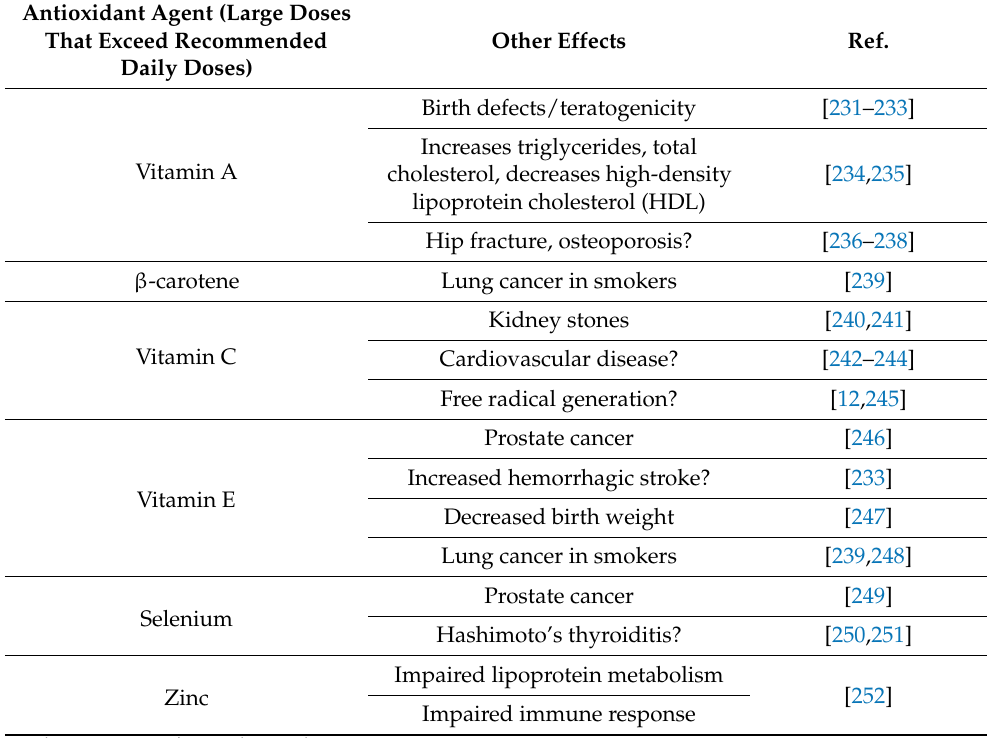
Table 1. Other effects related to excessive supplementation with different antioxidants. Antioxidant Agent (Large Doses That Exceed Recommended Daily